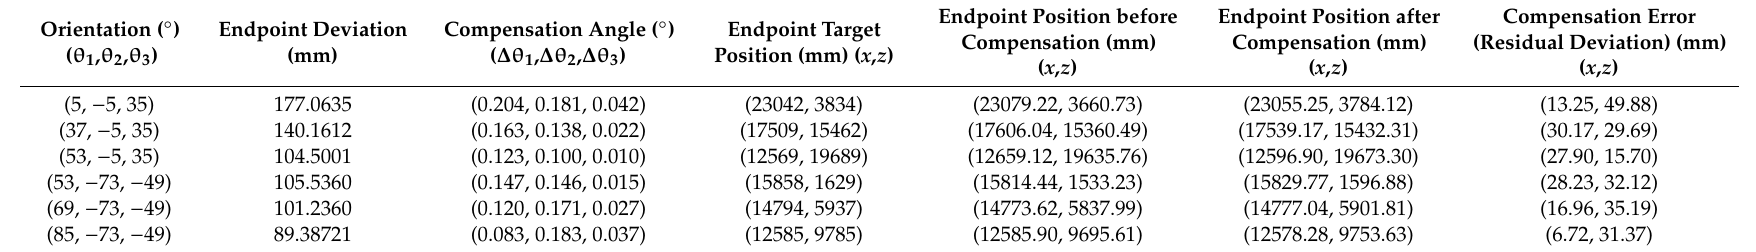
Table 2. Deformation compensation e ff ect of six common orientations.